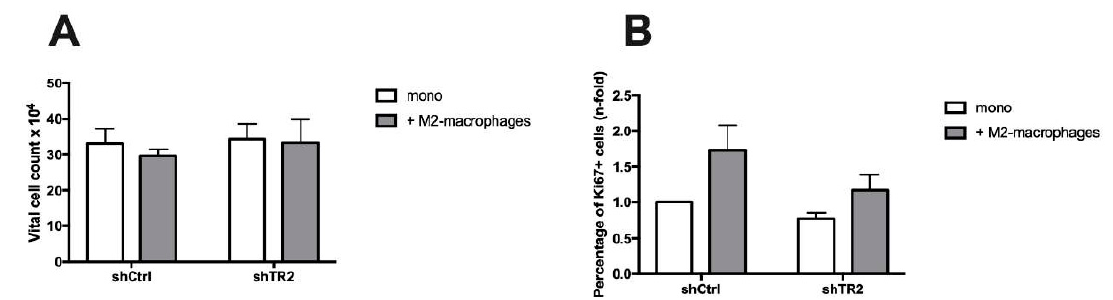
Figure 4. In vitro coculture with M2-macrophages does not differentially affect growth of PancTu-I shCtrl and shTR2 cells. PancTu-I shCtrl or PancTu-I shTR2 cells were indirectly cocultured in absence (mono) or presence of M2-macrophages (+ M2-macrophages) for one week. After coculture, ( A ) vital cell numbers and ( B ) Ki67 status were analyzed. Vital cell numbers were obtained by counting living cells in a Neubauer counting chamber. Ki67 status was determined by immunocytochemical Ki67 staining. Proportion of Ki67+ cells was normalized to monocultured PancTu-I shCtrl cells. Data represent the mean ± SEM of 4–5 independent experiments.